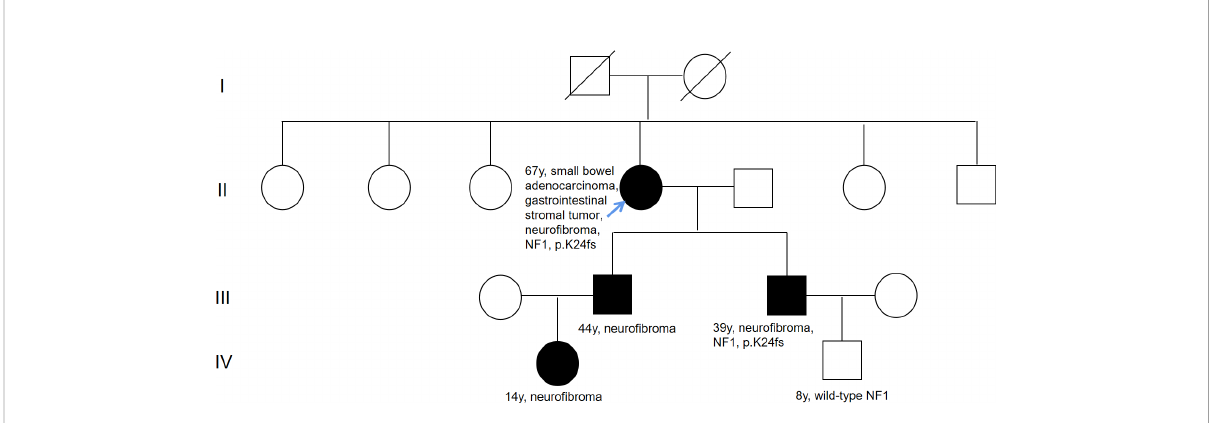
FIGURE 2 Pedigree of family. The black symbols indicate neuro fi bromatosis type 1. Numbers on right-top gives the current age. The blue arrow means the